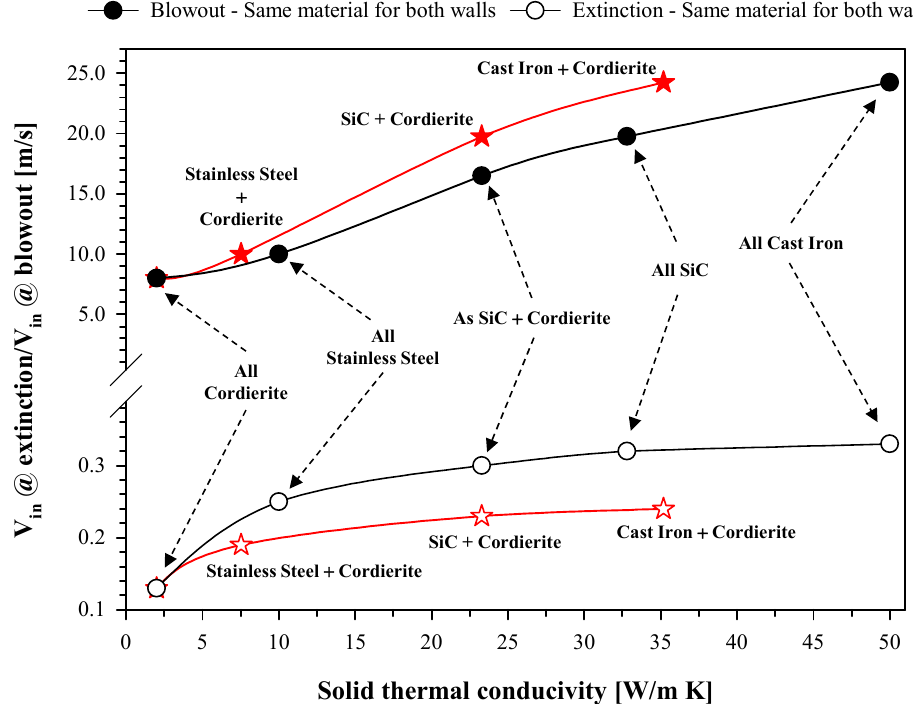
Figure 11. V in @ extinction and V in @ blowout versus the solid thermal conductivity: Optimal configuration and configuration with both walls made of the same material. (These are all cases of Table 3).